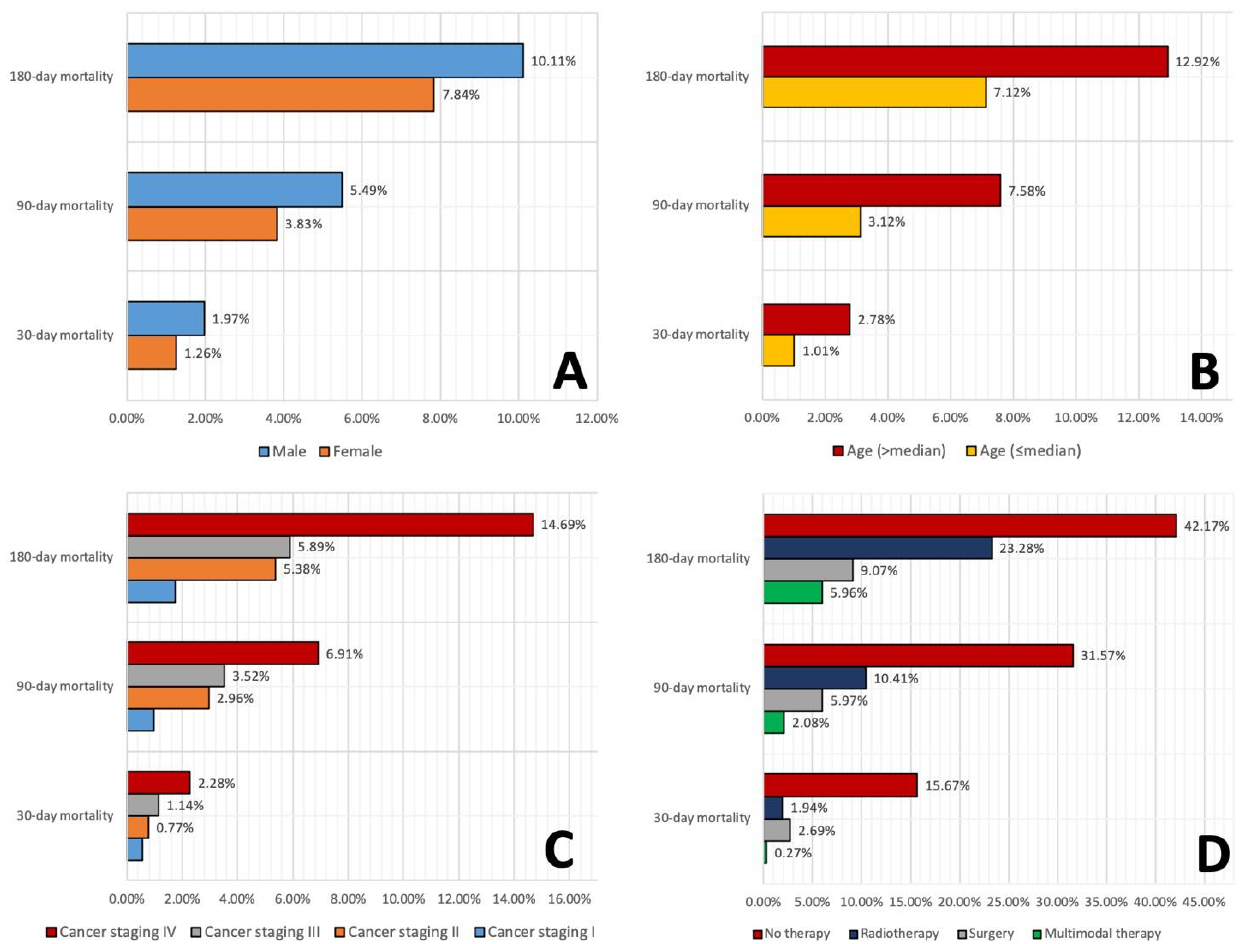
Figure 1. Distribution of 30-day, 90-day, and 180-day mortality according to gender ( A ), age in relation to the median of 60 years ( B ), cancer staging ( C ), and treatment ( D ).